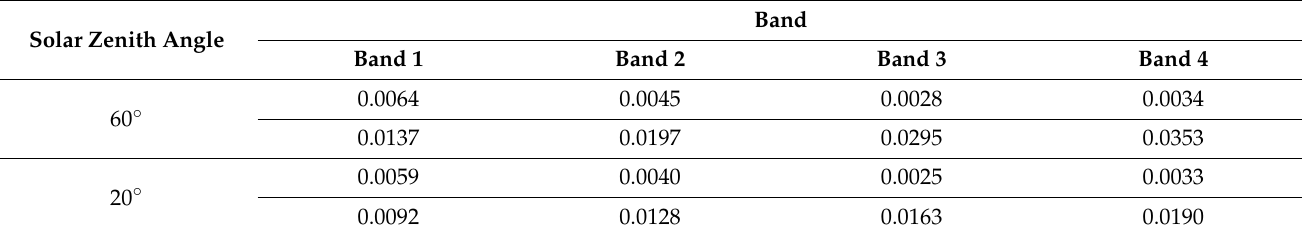
Table 7. RMSE of reflectance retrieval for dark surfaces (upper numbers) and bright surfaces (lower numbers) in the MZ spectral bands with an error 5% of radiometric calibration in the MS channel 412 nm. Solar Zenith